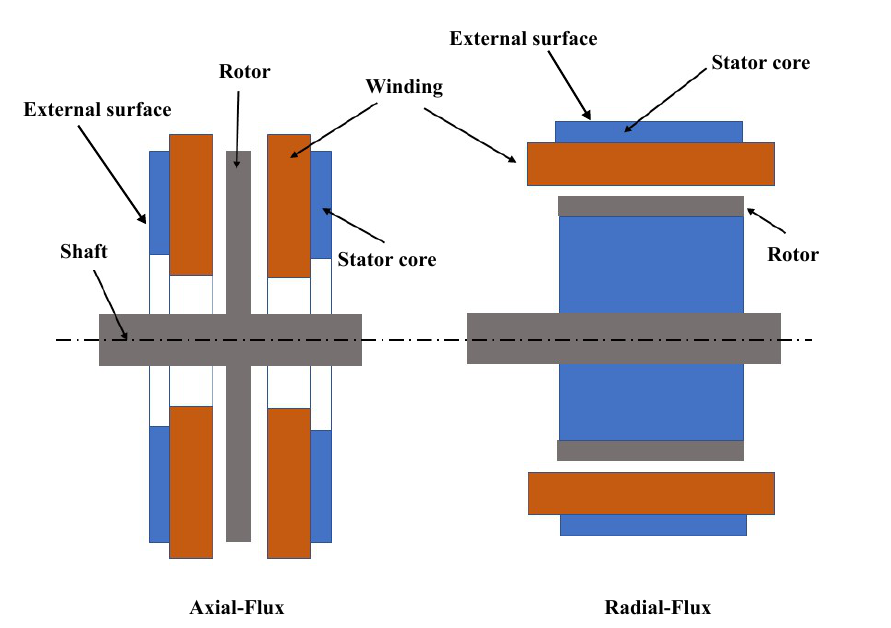
Figure 11. Structure illustration of a conventional RF machine compared to an AF